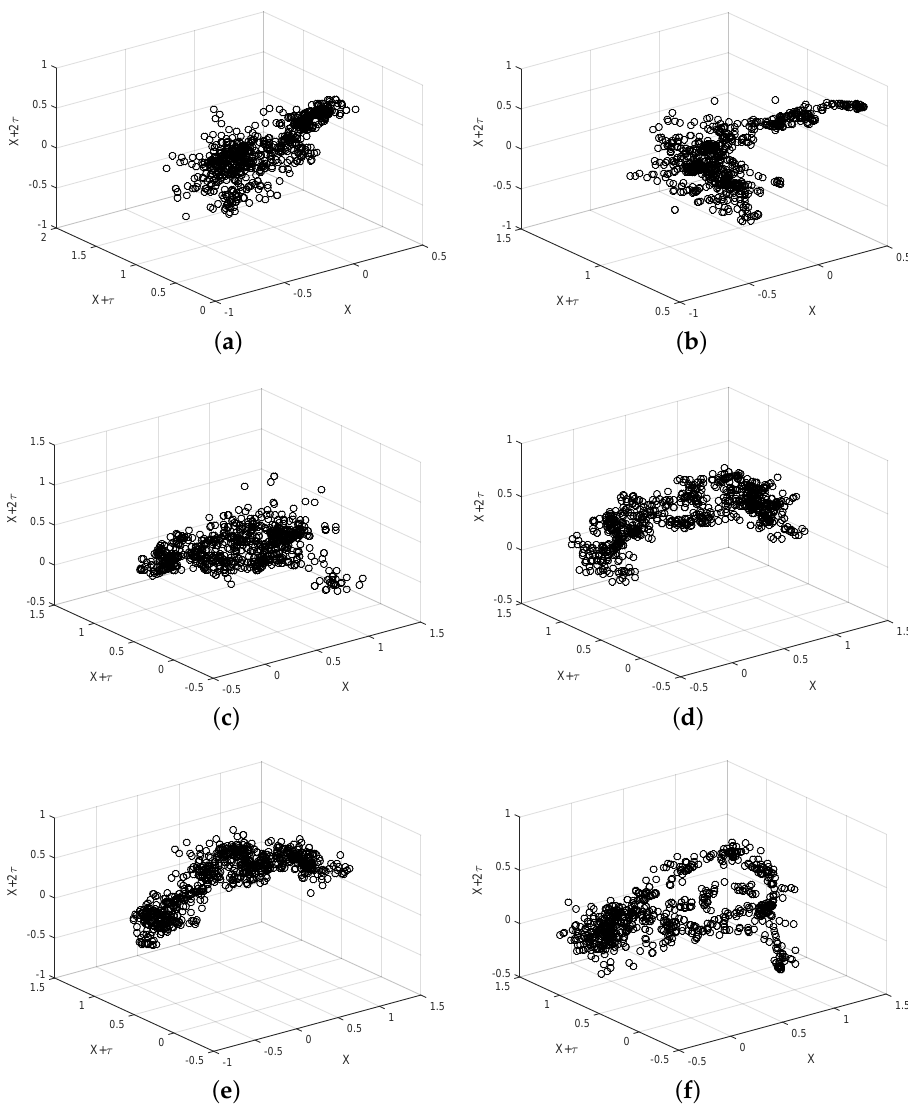
Figure 7. RPS with transitional activities. ( a ) A7; ( b ) A8; ( c ) A9; ( d ) A10; ( e ) A11; ( f ) A12. In Figure 7, because the activities A7–A12 describe the transition process between different motions, for each activity, the variation of amplitude is small. Thus, the divergence of the chaotic attractor trajectory of transition activities A7–A12 is less than the basic activities type A1–A6. In addition, the chaotic attractor of activities A9, A10, A11, and A12 “attempt to escape” the center of trajectory more than the activities A7 and A8, which is related to the magnitude of motion amplitude in the process of action